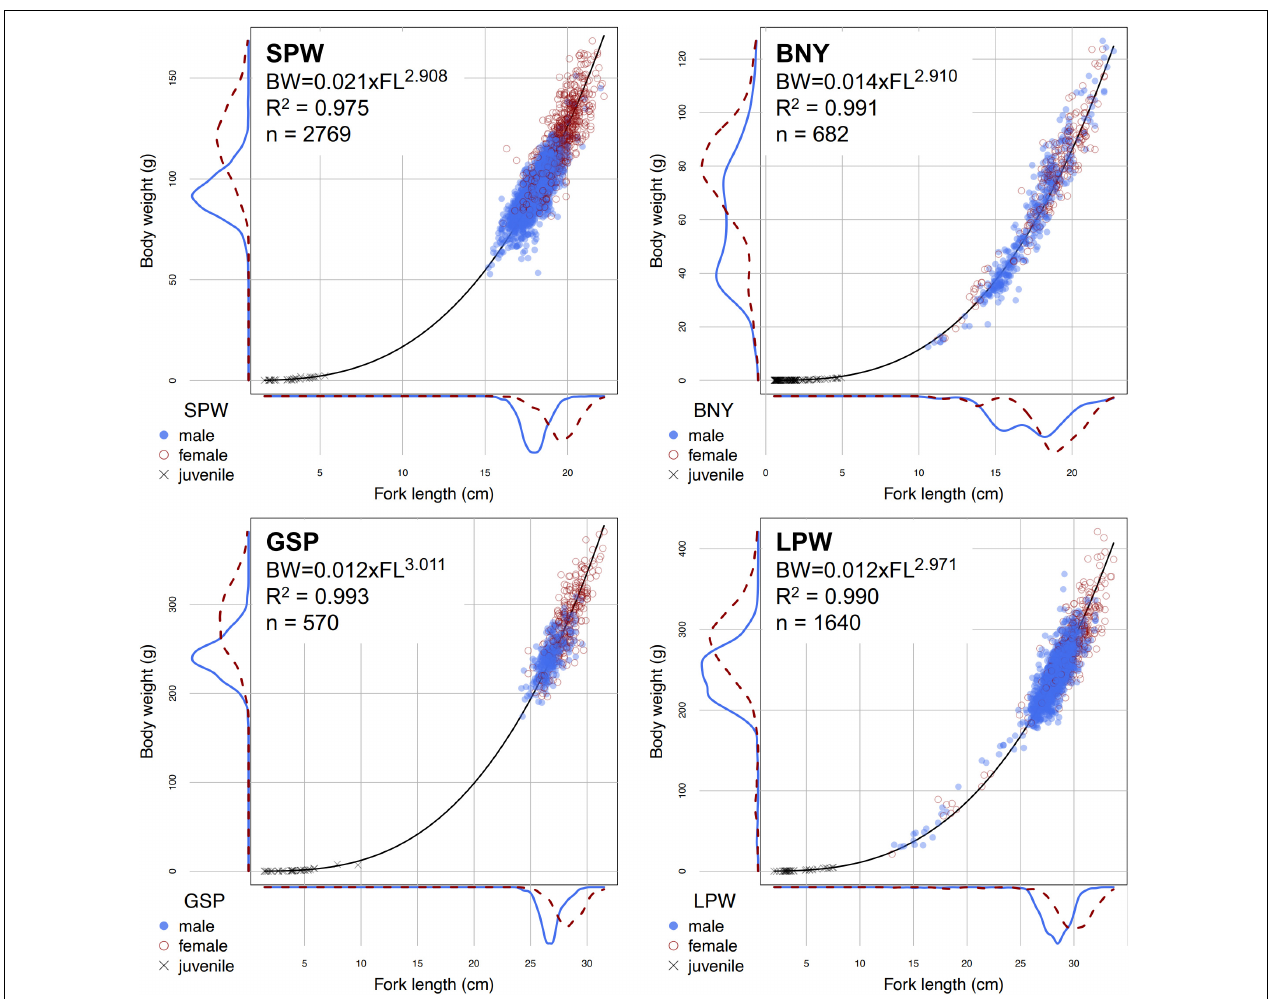
FIGURE 3 | Fork lengths (FL) and total body weights (BW) data, as well as the estimated length-weight equations, of the four major flyingfishes that were used in this study. SPW, spotwing flyingfish; BNY, bony flyingfish; GSP, greater spotted flyingfish; LPW, limpidwing flyingfish. Data were from port sampling and at-sea survey programs, except for juvenile fish samples of BNY and GSP which included data from hatching